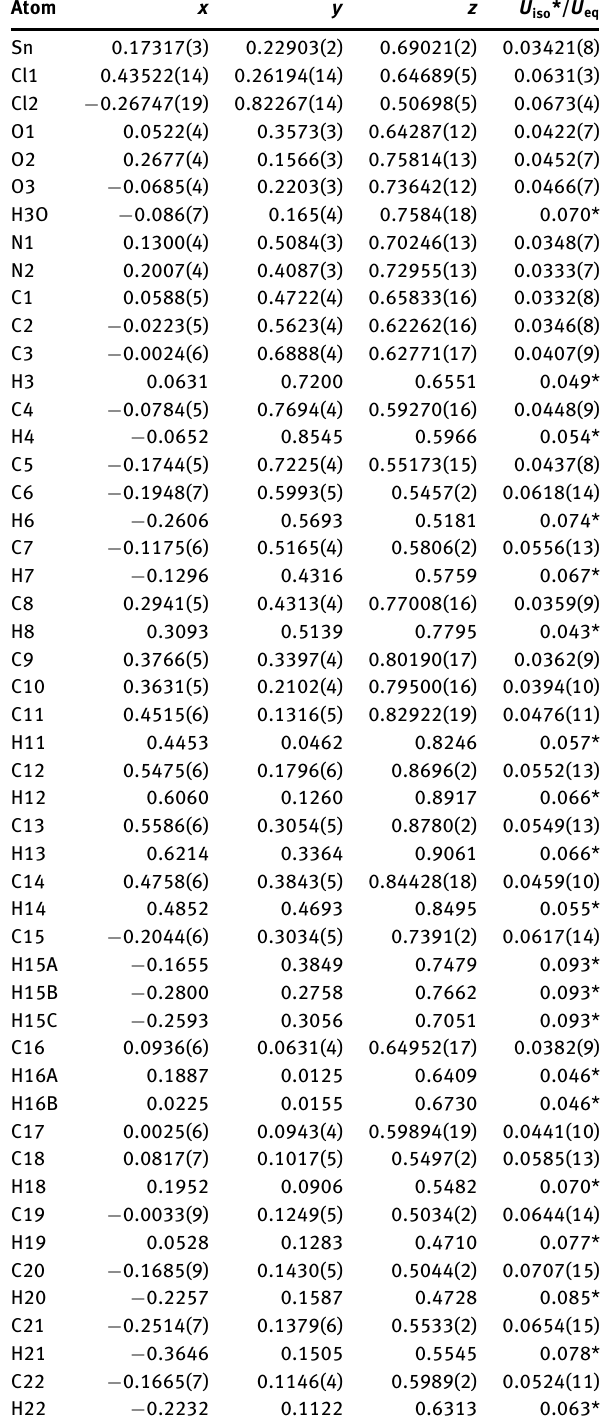
Table 2: Fractional atomic coordinates and isotropic or equivalent isotropic displacement parameters (Å 2 ).